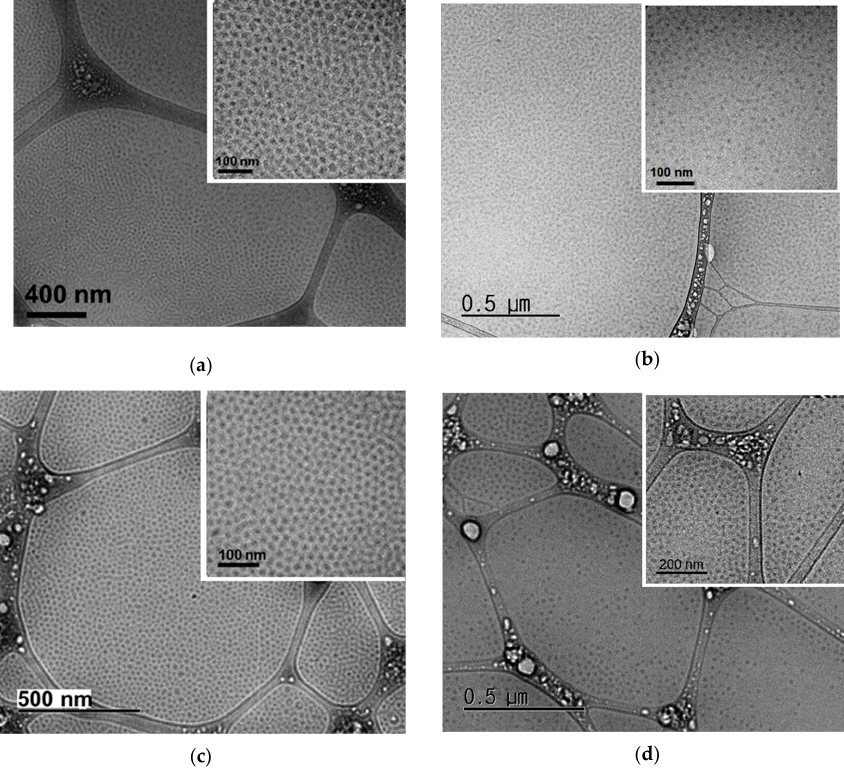
Figure 4. Cryo-TEM images obtained from 0.5 wt % C3Ms for ( a ) A + S; ( b ) A + C; ( c ) G + S; and ( d ) G + C in an aqueous solution. Insets are images of high resolution.